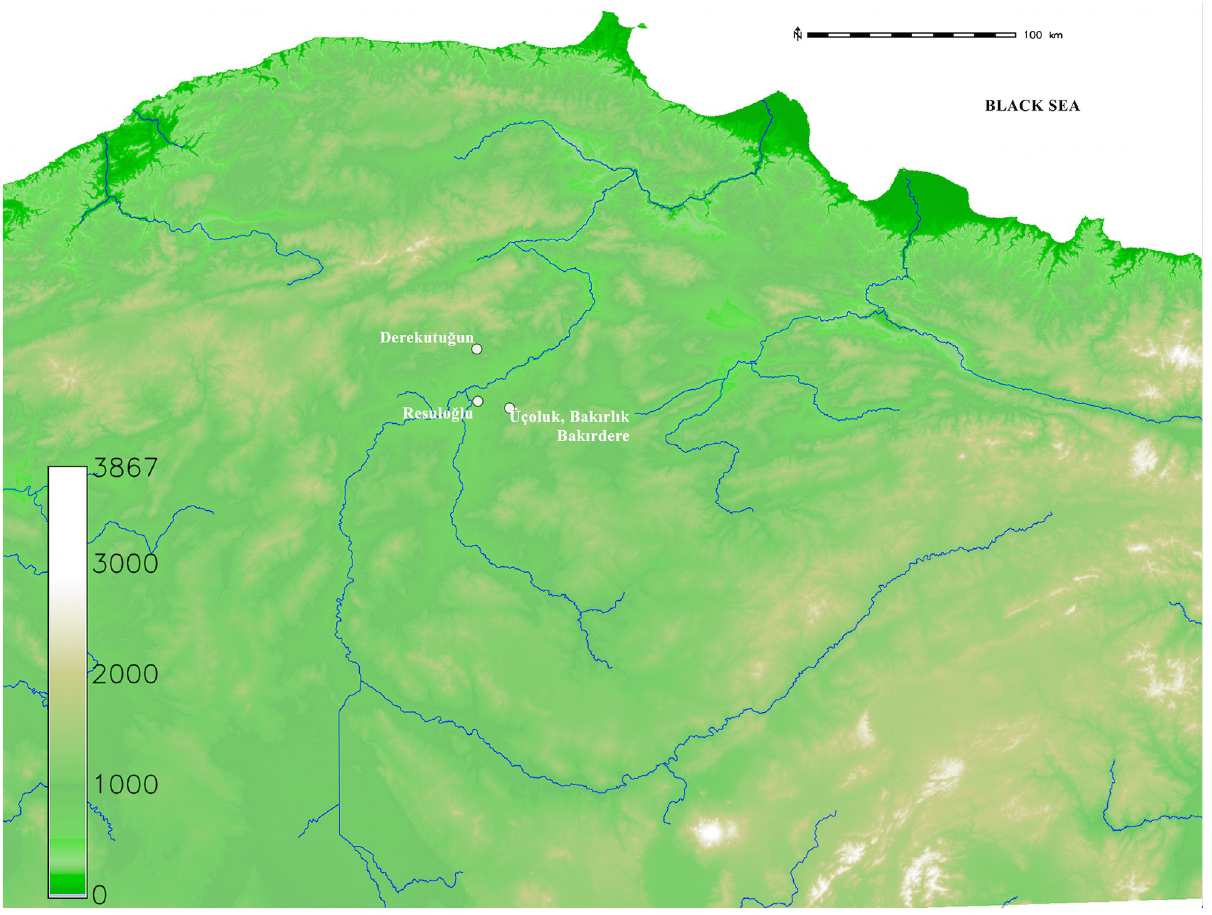
Fig 7. Map showing the research area of the Delice Valley Survey (image courtesy of Bu¨lent Arıkan).